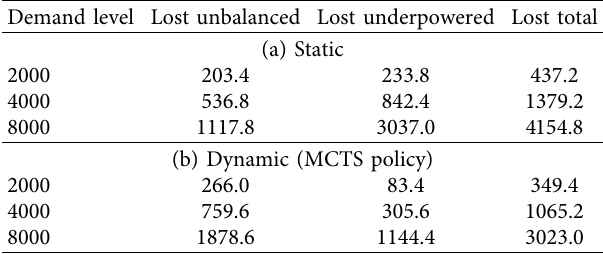
Table 3: Number of lost users under dynamic and static operation.